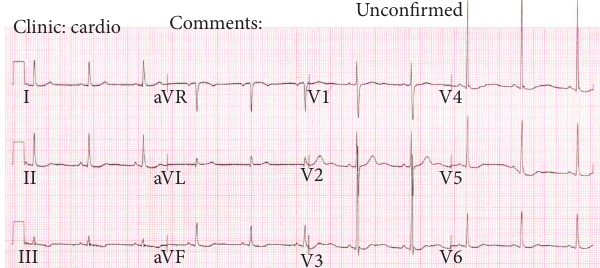
Figure 2: ECG on